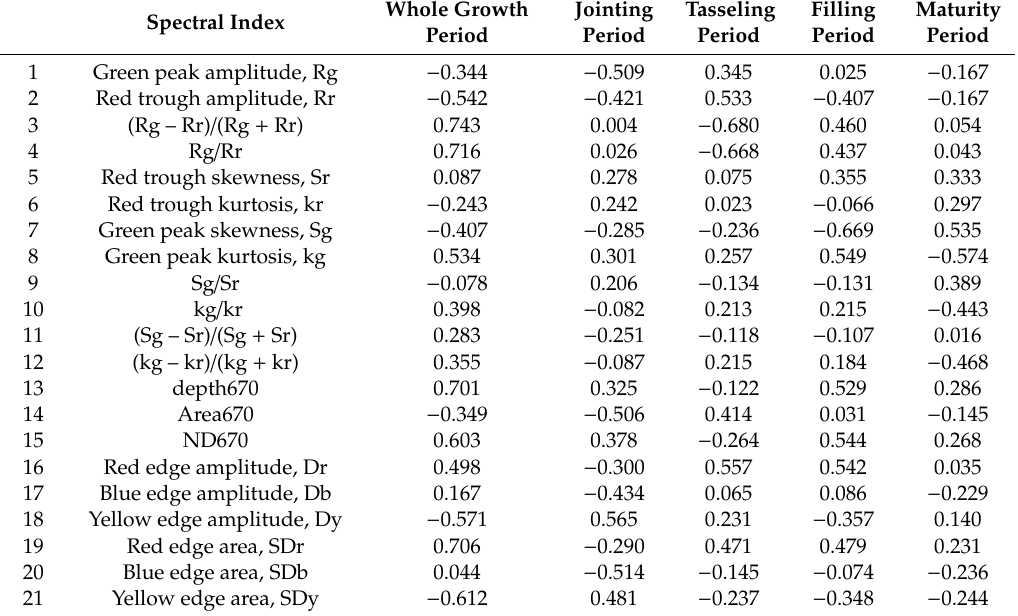
Table 4. Correlation coe ffi cients between summer corn canopy nitrogen concentration and spectral index (two